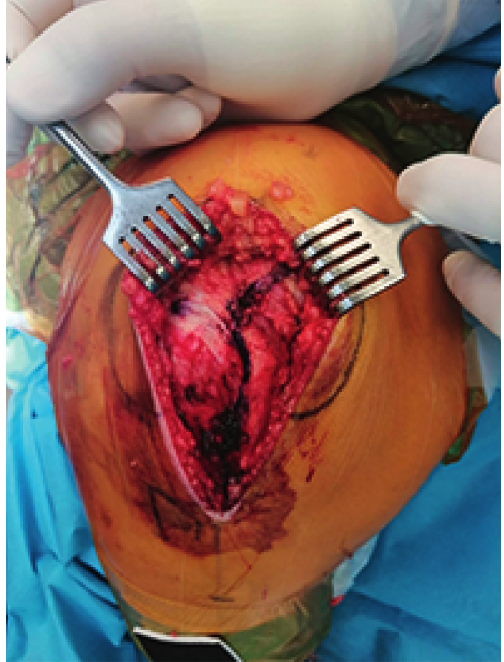
Figure 3: Preoperative image demonstrating midvastus